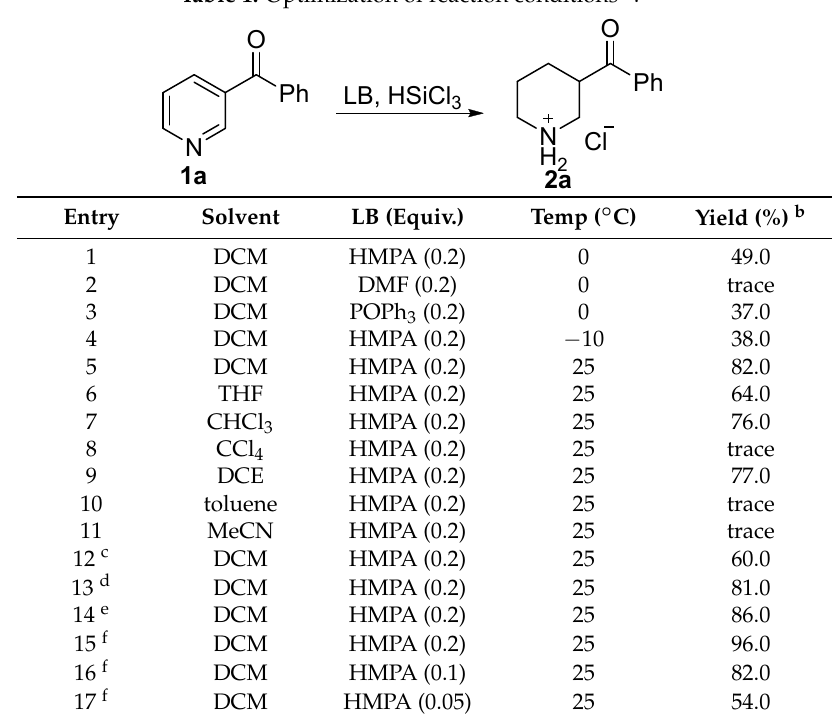
Table 1. Optimization of reaction conditions a .